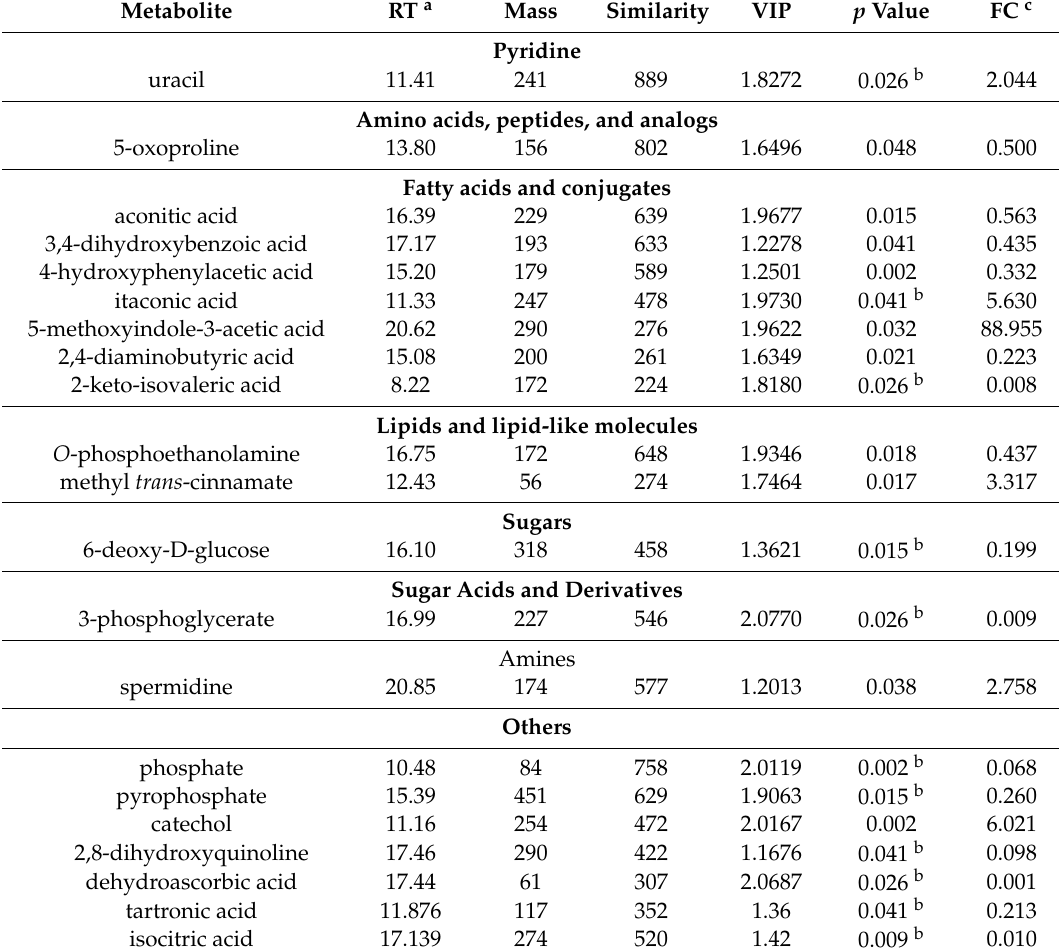
Table 4. Significant di ff erential metabolites between Groups C and H (VIP > 1.0; p <